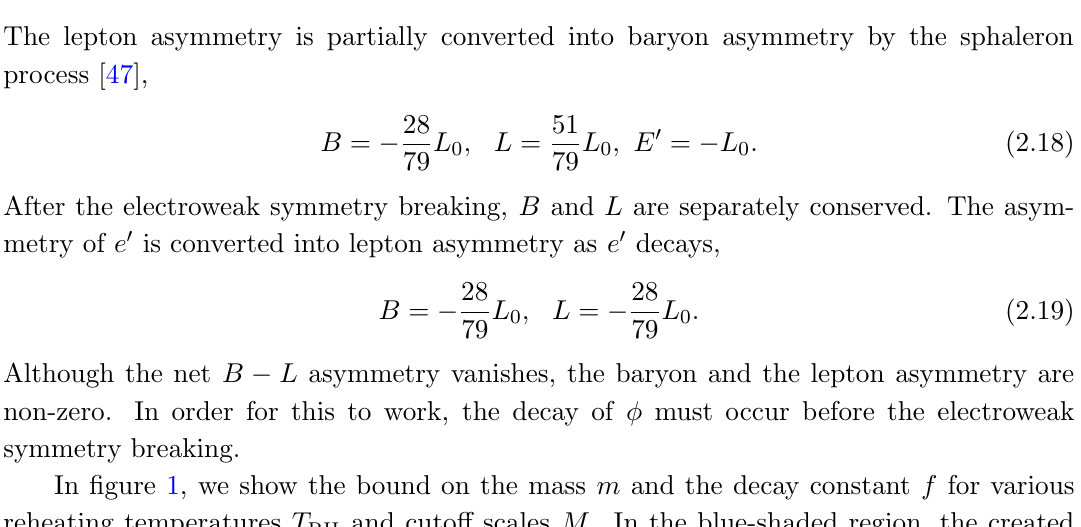
Figure 1 . Constraints on the mass m and the decay constant f of the NGAD